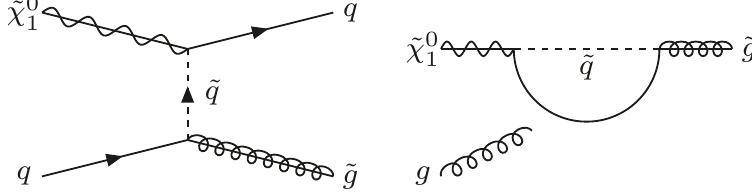
Figure 5. Diagrams for the conversion between the neutralino and